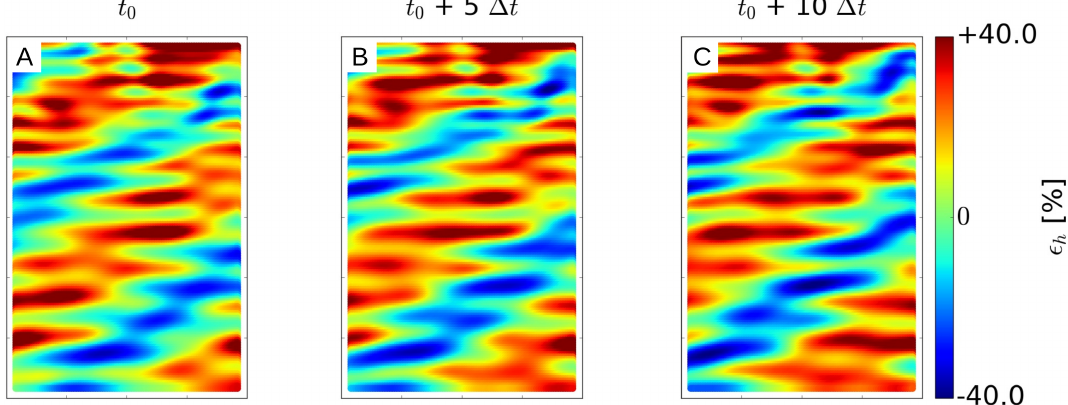
Figure 14. Propagation of the errors (cid:101) h in the bathymetry inversion for three time